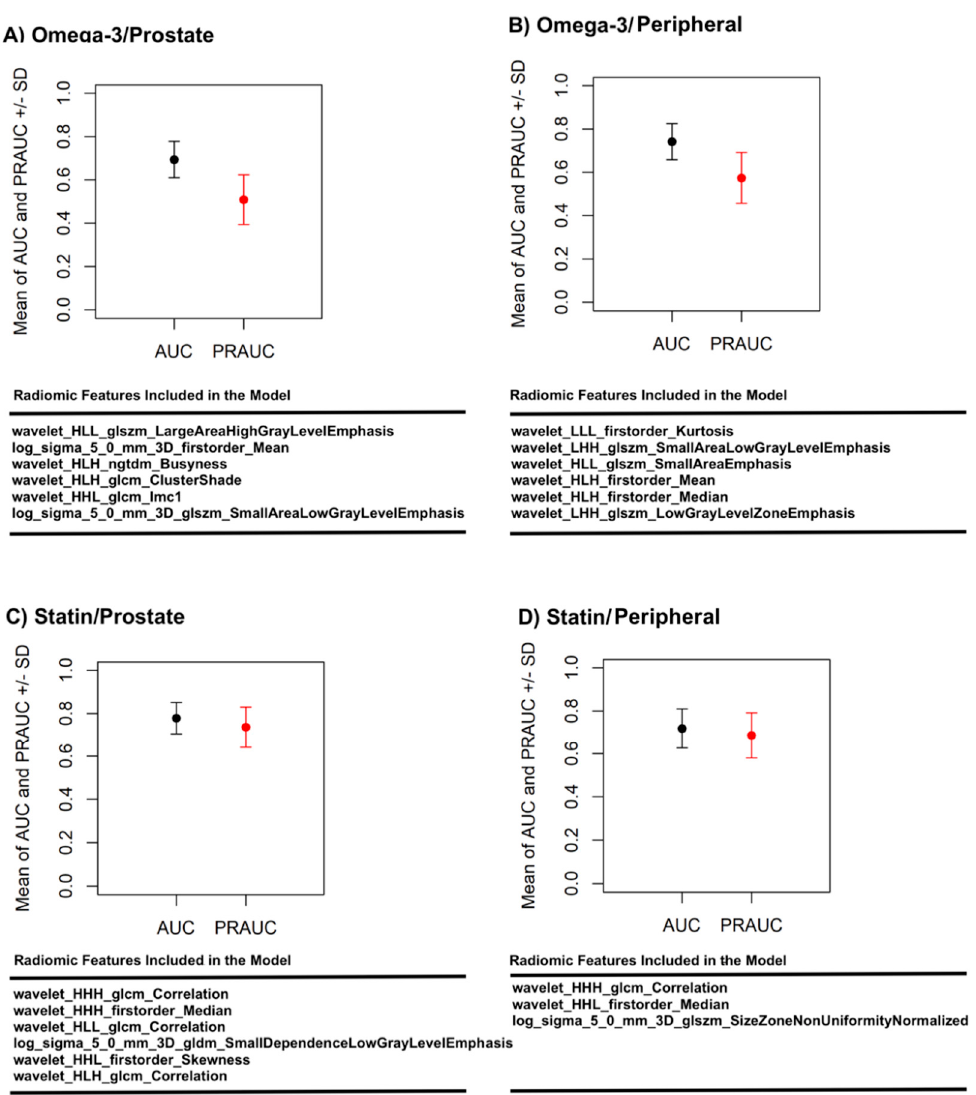
Figure 5. Area under the curve (AUC) and precision AUC (PRAUC) achieved on the 1500 validation sets by the radiomics model for ( A ) omega ‐ 3 usage prediction based on prostate ROI, ( B ) omega ‐ 3 usage prediction based on peripheral ROI, ( C ) statin usage prediction based on prostate ROI, and ( D ) statin usage prediction based on peripheral ROI. The radiomic features used in each model are also listed.